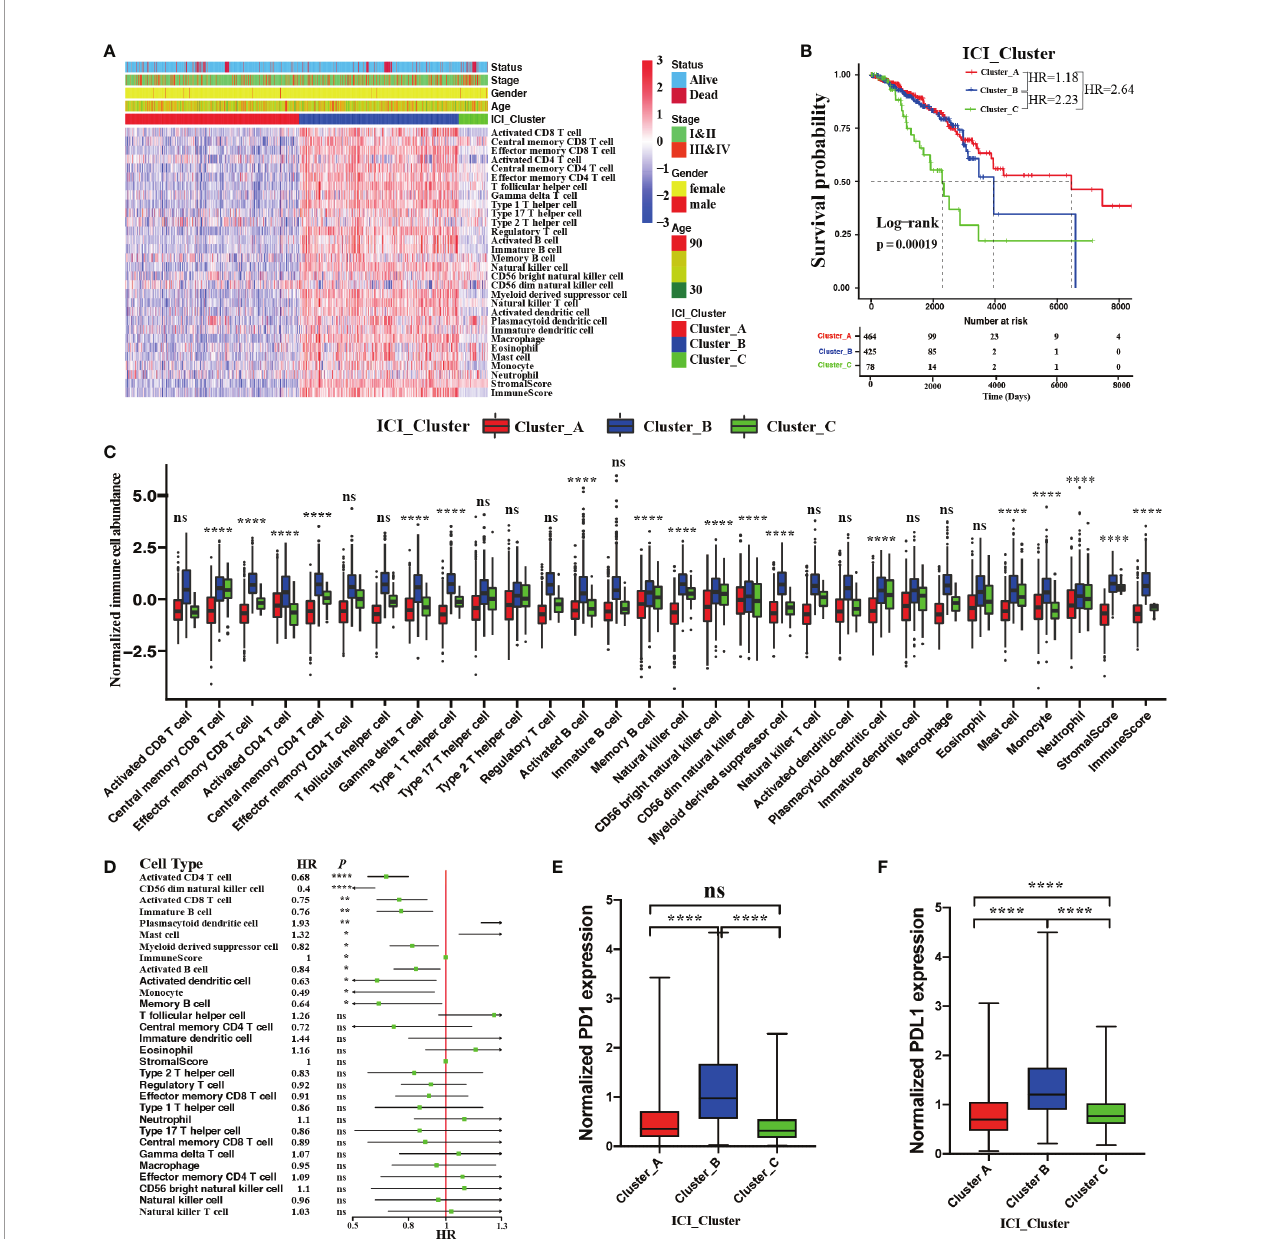
FIGURE 2 | The ICI landscape in the TME of BRCA. (A) Unsupervised clustering for ICI phenotypes in the TME. The rows represent immune cells, and the columns represent BRCA samples. (B) The Kaplan – Meier curves showing OS (overall survival) outcomes in BRCA patients among these distinct ICI clusters. Log-rank test showing P = 0.00019. (C) The normalized immune cell abundances and stromal cell contents with distinct ICI clusters. (Kruskal – Wallis test, ns, no signi fi cance P > 0.05; **** P < 0.0001). (D) The prognostic role of immune cell abundance and stromal cell content. (Univariate Cox regression model, ns P > 0.05; * P < 0.05; ** P < 0.01; **** P < 0.0001). Comparison of the expression level of two vital immune checkpoint molecules with these distinct ICI clusters; PD1 (E) and PD-L1 (F) . (Wilcoxon test, ns P > 0.05; **** P <